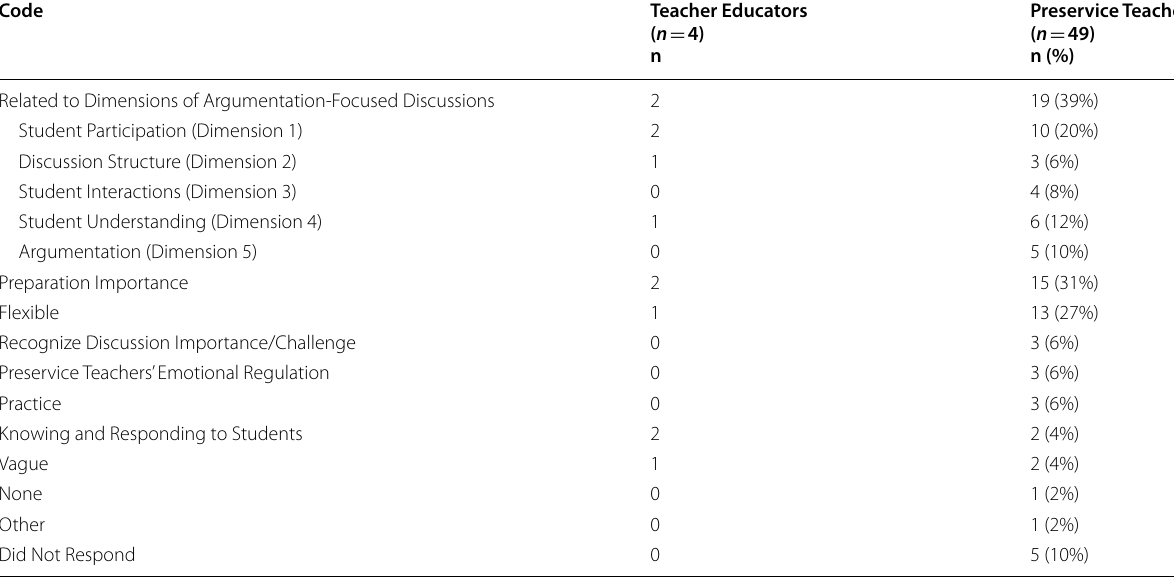
Table 3 Results for Perceptions of Learning from the Simulated Teaching Experience